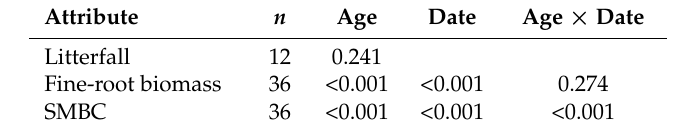
Table 3. The effects ( p values) of stand age (Age) and sampling date (Date) on litterfall production